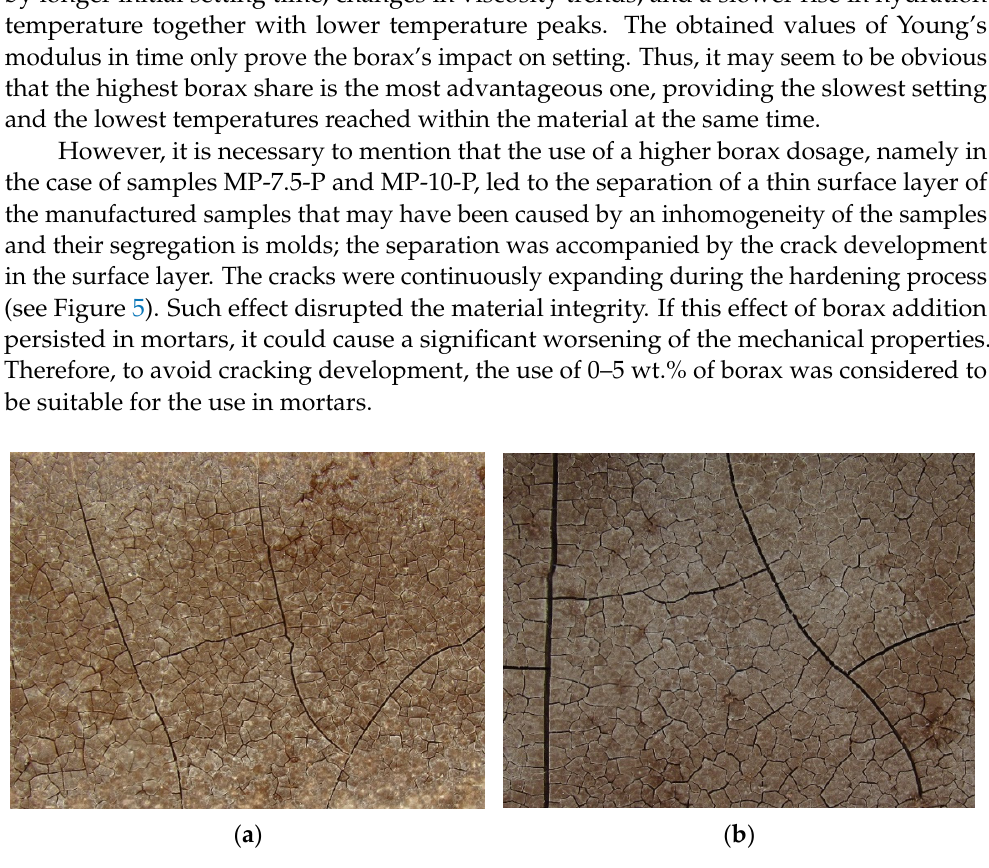
Figure 5. Network of cracks formed in the surface layer in the case of the samples with borax ad- dition exceeding 5 wt.%; ( a ) MP-7.5-P and ( b )